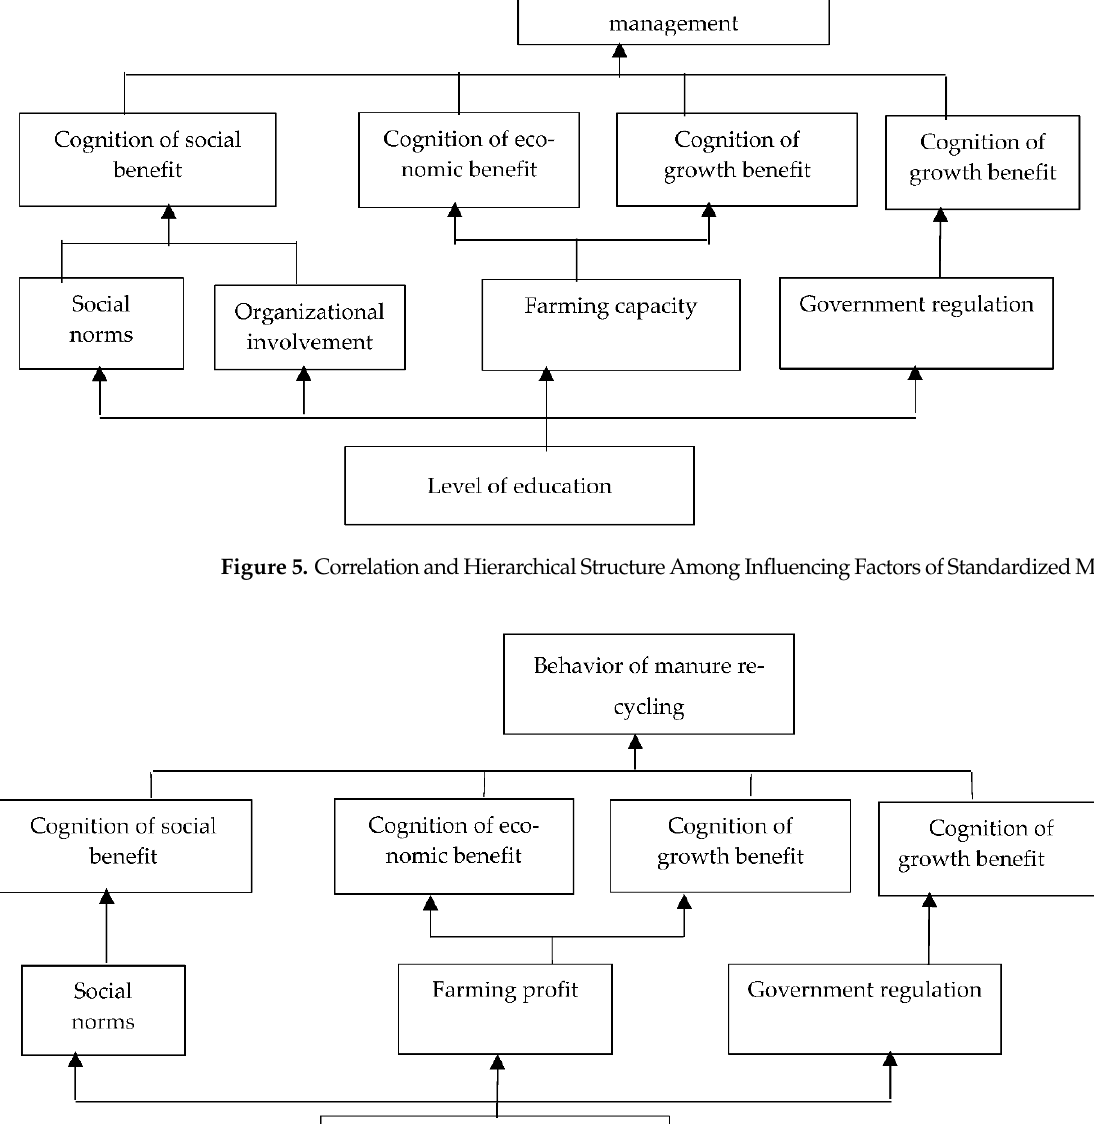
Figure 4. Correlation and Hierarchical Structure Among Influencing Factors of Scientific Epidemic Control.